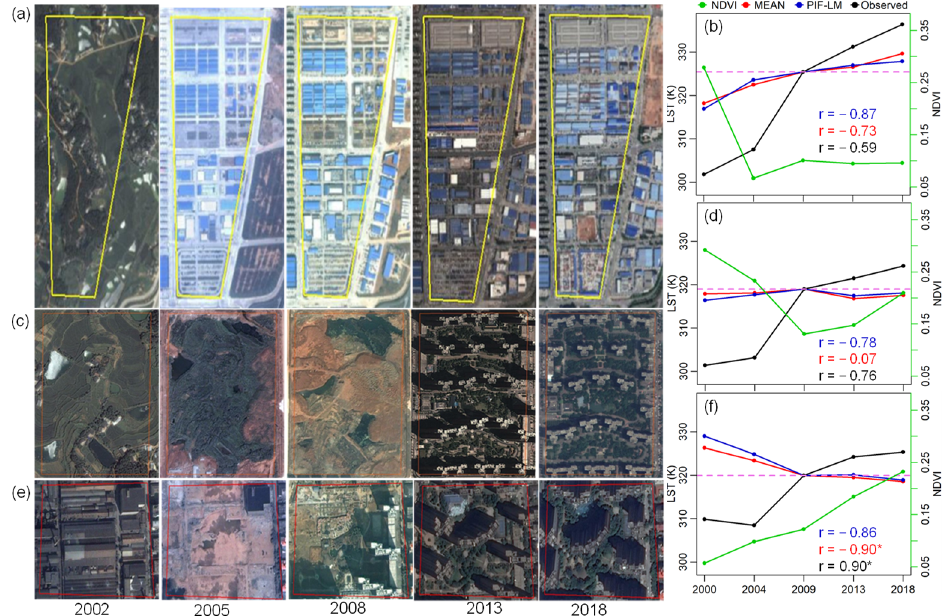
Figure 11. Land conversion ( a , c , e ) and the corresponding LST and NDVI change ( b , d , f ) for three example function units. Black line: observed LST; blue line: PIF-LRM normalized LST; red line: MEAN normalized LST; green line: NDVI. The purple dashed line indicates LST in 2009. * indicates P < 0.05, ** indicates P < 0.01.